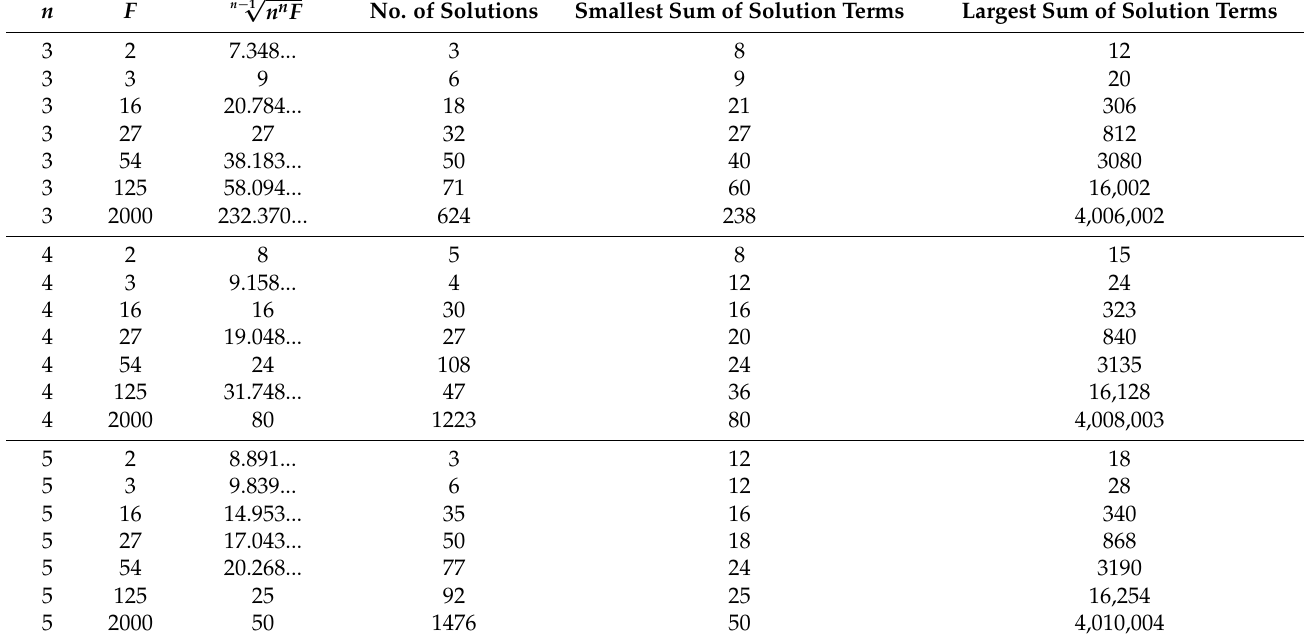
x i = F ∑ n x i ; x i , F ∈ Z + for selected n and F i = 1 i = 1